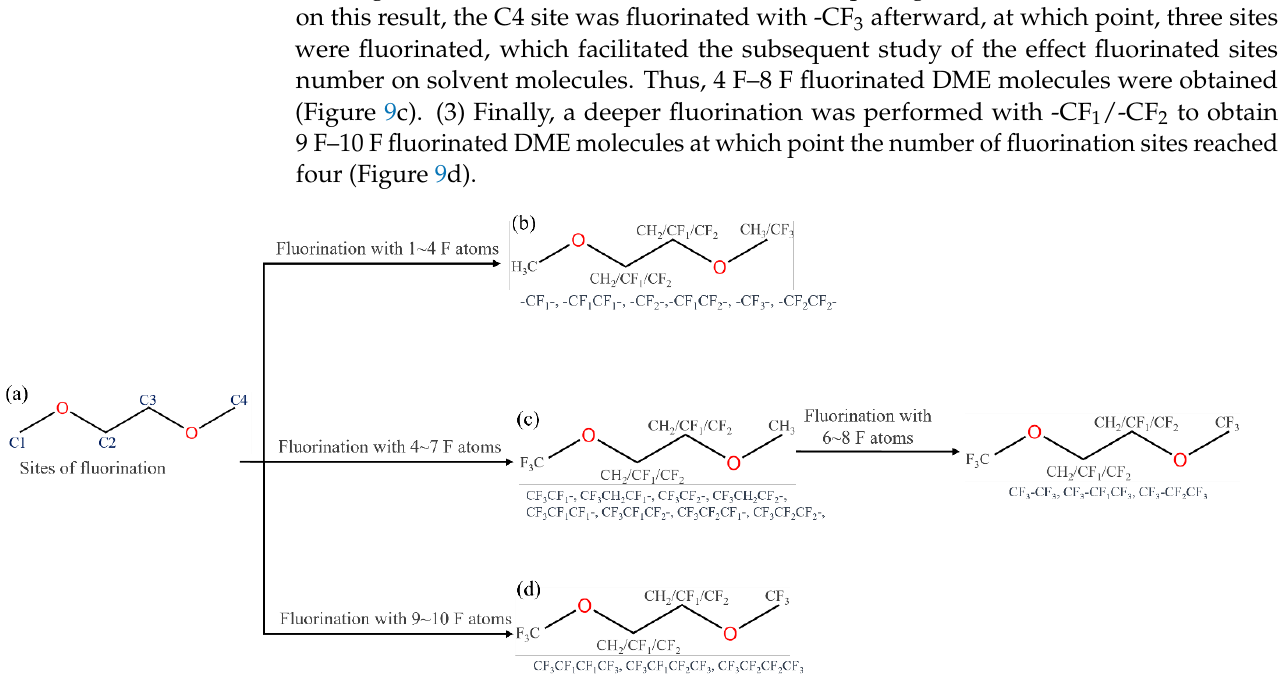
Figure 9. Fluorinated sites of DME ( a ) and detailed fluorination of DME with 0 – 4 F ( b ), 4 – 8 F ( c ), and 9 – 10 F ( d ).